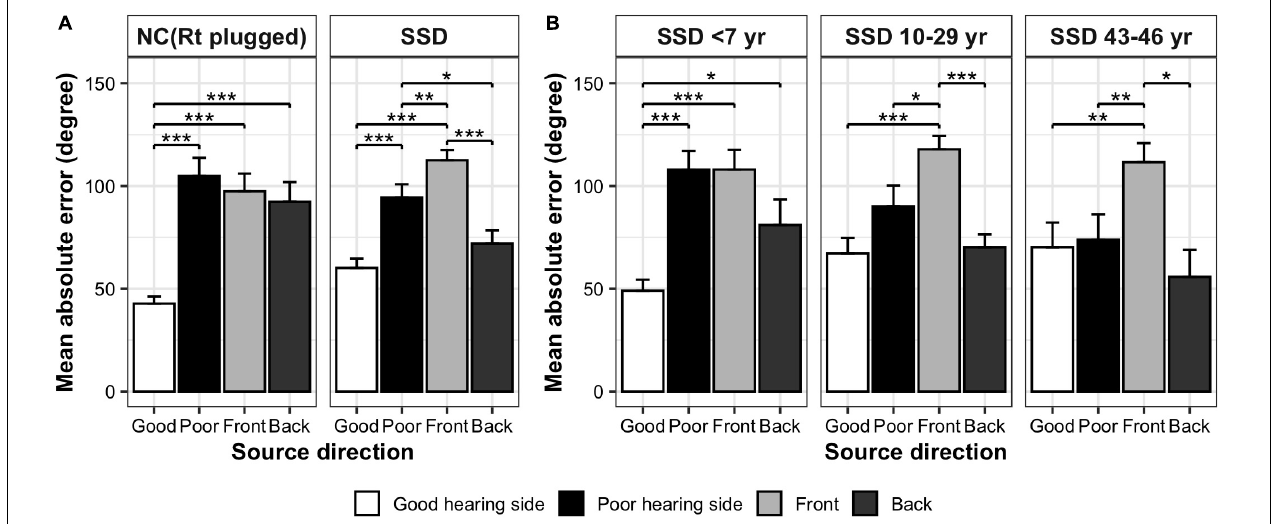
FIGURE 3 | Comparison of MAE values in four directions (mean ± SE). (A) NC (acutely plugged) group and SSD group. (B) SSD subgroups with different duration of SSD. *** p < 0.001; ** p < 0.01; * p < 0.05.